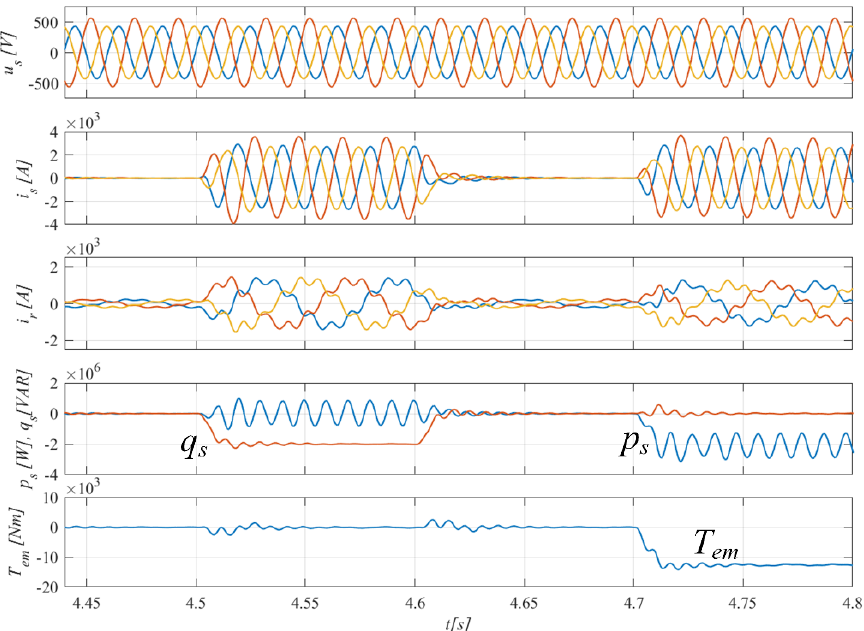
Figure 9. Simulation results of DPC in case of symmetrical grid voltage with the feedforward and decoupling mechanism. The stator current signal contains information about the rotor value.